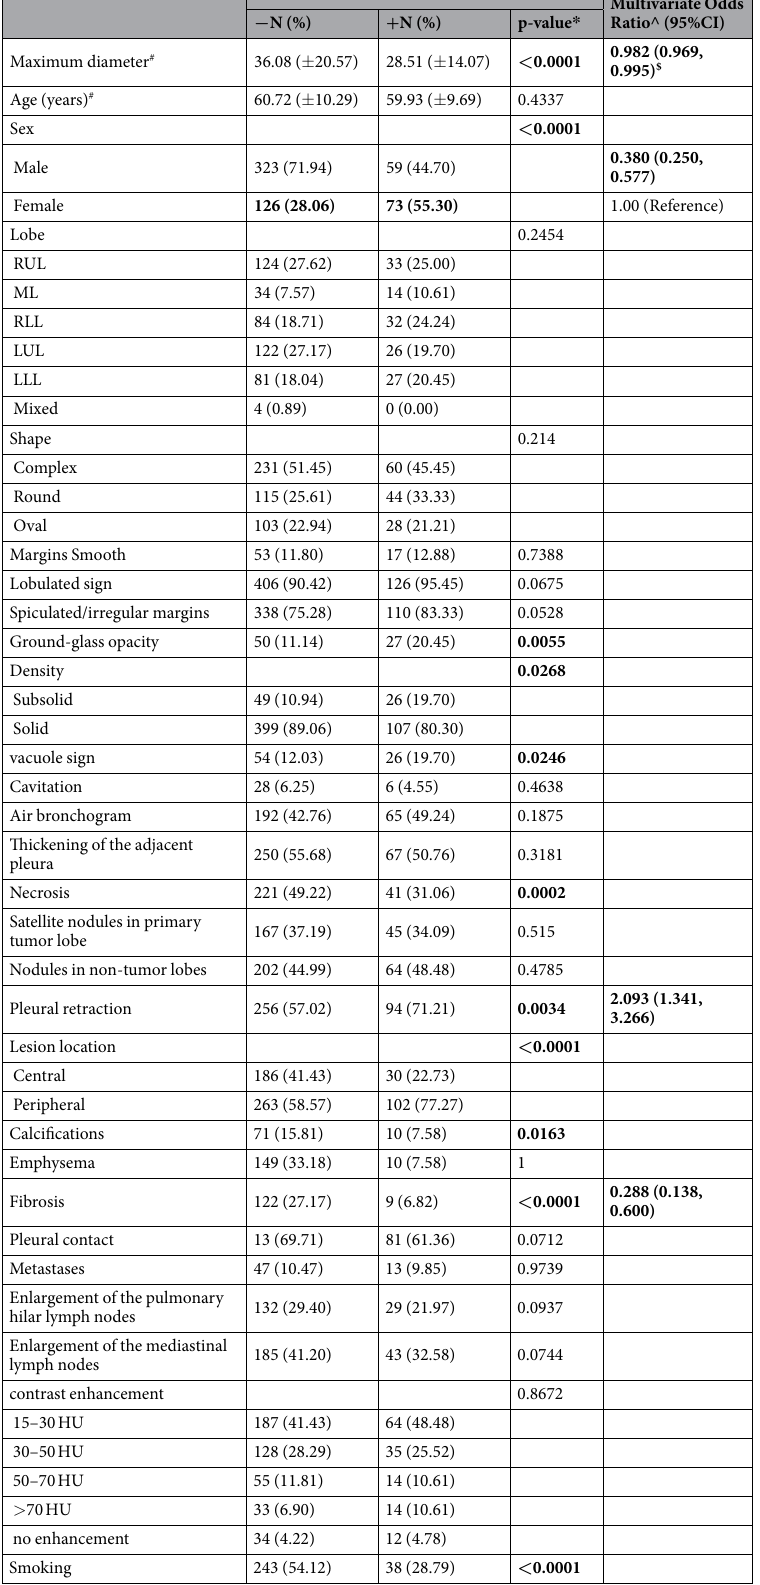
Table 2. Univariate and multivariate analyses of the EGFR wild type and EGFR mutation in exon 19. CI = Confidence interval. Note: significant ORs and p-values are in bold. # Mean ( ± SD). * Non-parametric two-sample Wilcoxon test for continuous variables. * Chi-square test and Fisher’s test for categorical variables. ^Obtained by logistic regression model with stepwise selection of variables. $ Per 10-mm